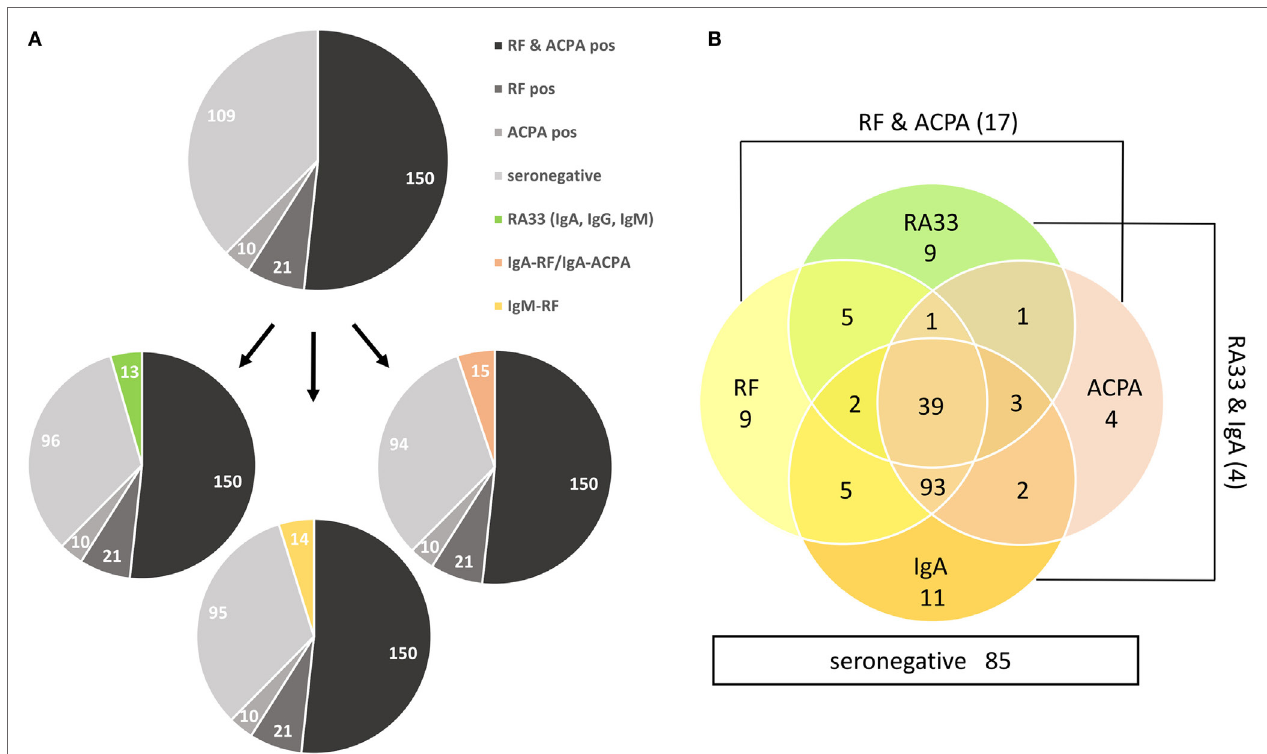
FigUre 3 | Added diagnostic value of IgA-rheumatoid factor (RF)/anti-citrullinated protein antibodies (ACPA), IgM-RF and RA33 antibodies. (a) Numbers of patients tested positive by routine diagnostics (RF nephelometry, IgG-ACPA) and seronegative patients (upper pie chart) showing additional RA33 antibodies (lower left pie chart), IgM-RF (lower middle pie chart) or IgA-RF/ACPA (lower right pie chart). (B) Venn chart visualizing the diagnostic overlap of RA33 and IgA antibodies with routine diagnostics (RF nephelometry, IgG-ACPA). The numbers of seronegative patients ( n = 85), RF, and IgG-ACPA positive but RA33 and IgA-RF/ACPA negative patients ( n = 17) as well as patients positive for both RA33 and IgA-RF/ACPA but negative for RF and ACPA ( n = 4) are also